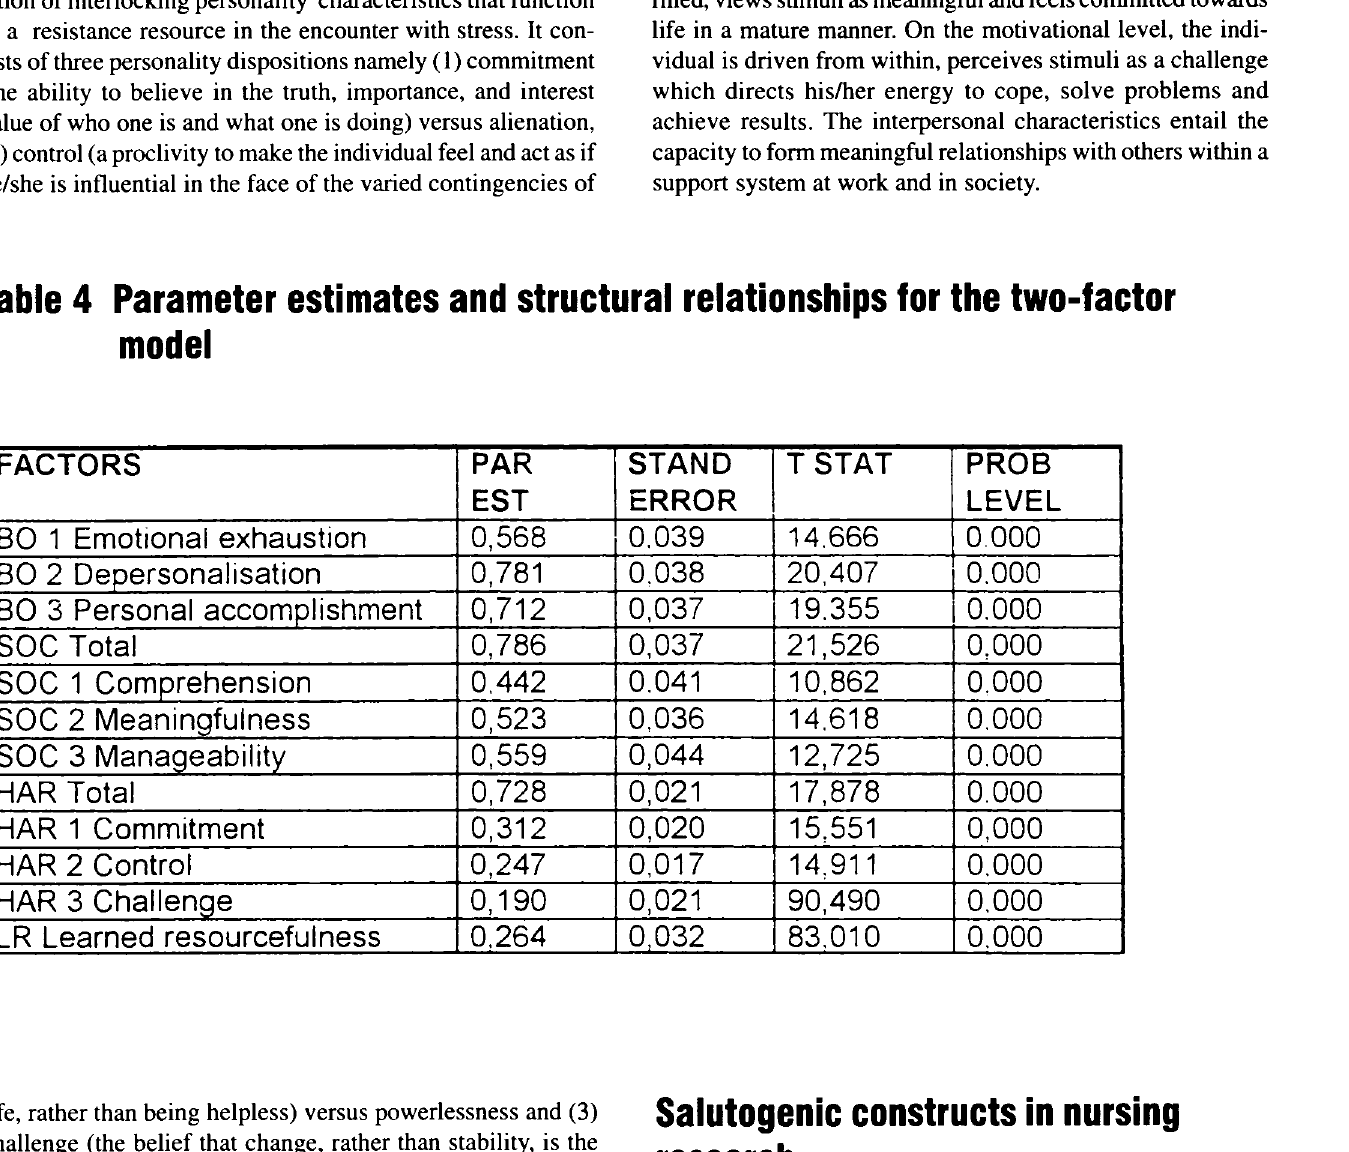
Table 4 Parameter estimates and structural relationships for the two-factor